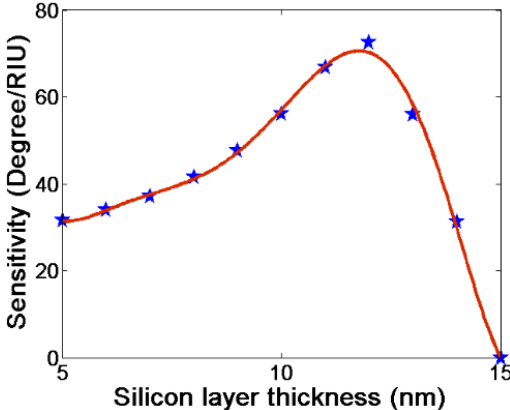
Figure 9. Sensitivity variation with silicon layer thickness for bio sensing probe with 50 nm of Au and four layers of graphene. Maximum sensitivity is calculated to be 72.60 degree/RIU. The star symbols are simulated data points, which are fitted with red line.